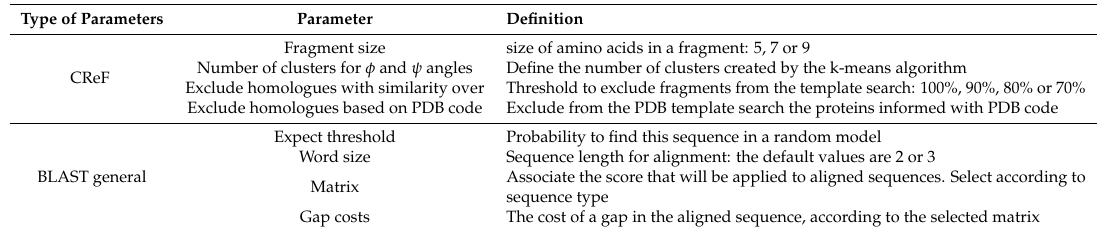
Table 6. Optional wCReF